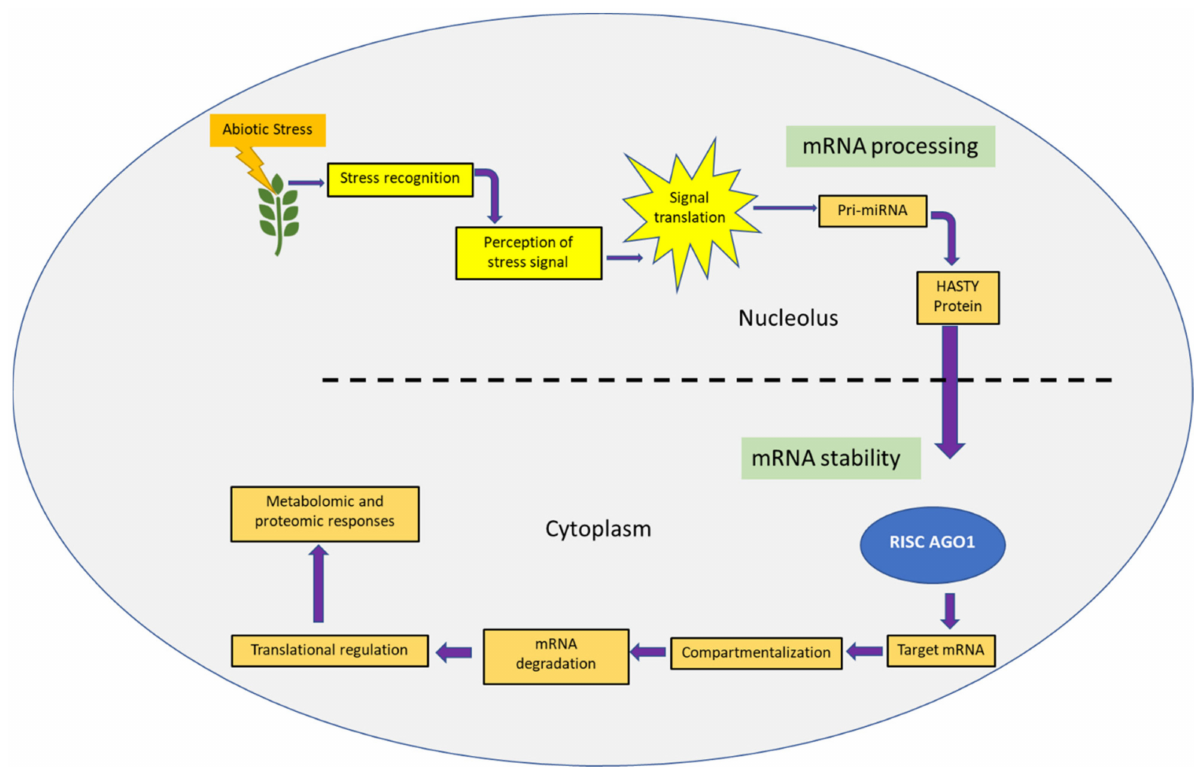
Figure 4. Pathway showing the steps involves in post transcriptional regulation mediated by abiotic stress-responsive miRNA genes in plants. Adapted from